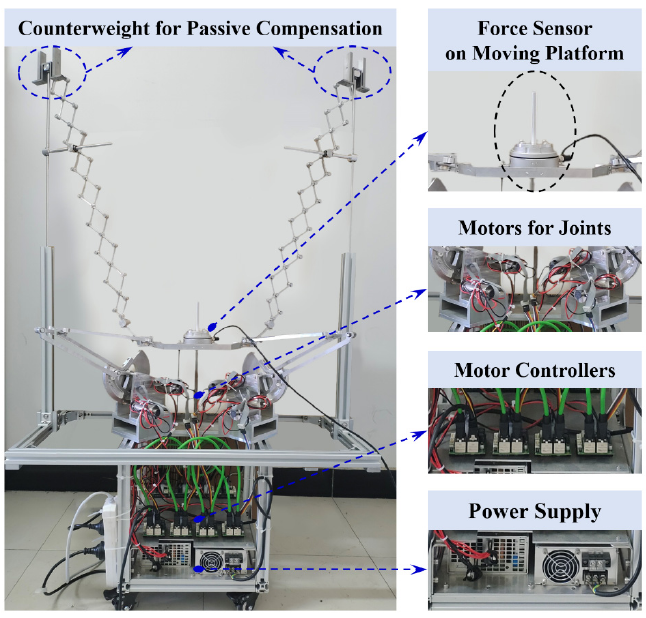
Figure 9. Prototype of the haptic device for experiments.